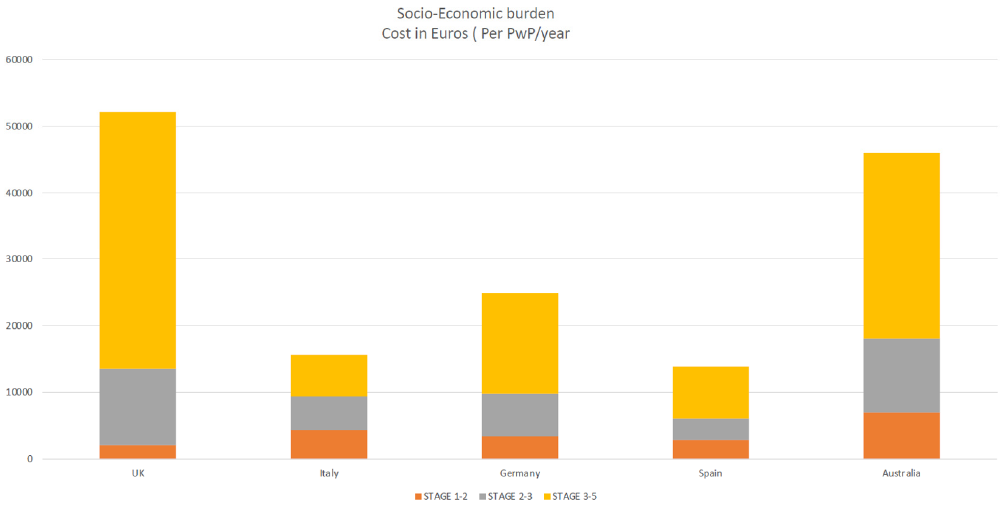
Figure 3. highlighting socio-economic burden increases as disease progress